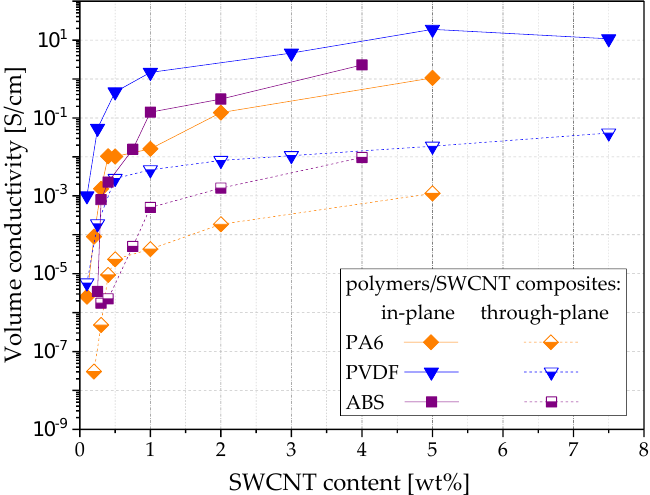
Figure 10. SEM micrographs of polyamide 6 (PA6) and acrylonitrile butadiene styrene (ABS) filled with 1.0 wt% of SWCNT.